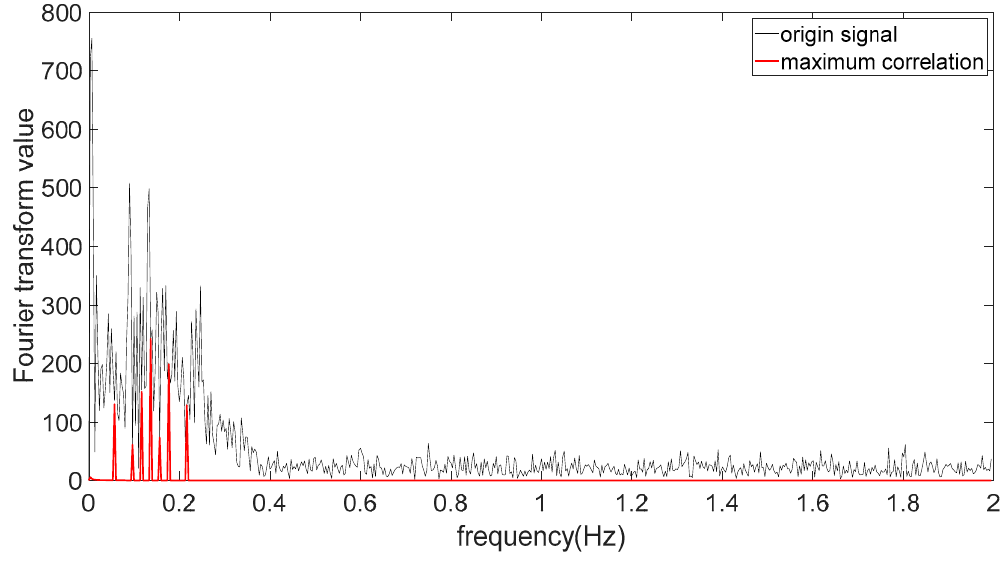
Figure 11. Frequency distribution of raw pixel intensity signal.